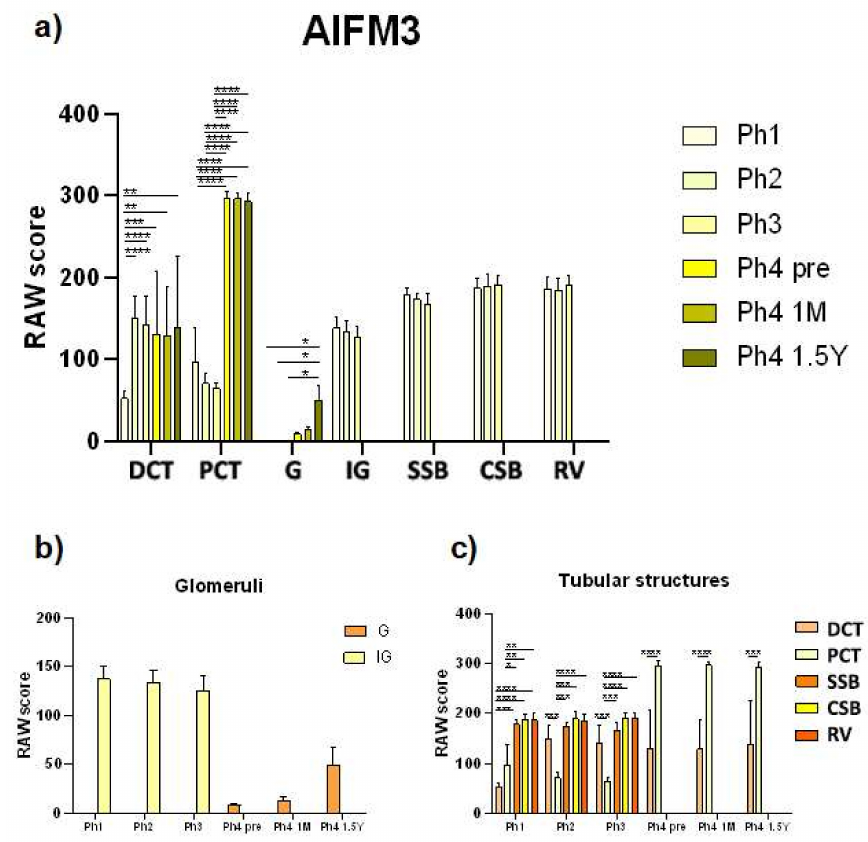
Figure 2. RAW scores of AIFM3 in the cortical nephron structures of human fetal and